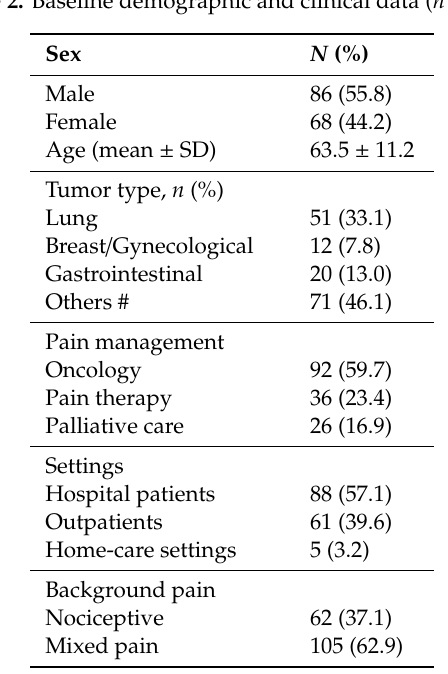
Table 2. Baseline demographic and clinical data ( n =